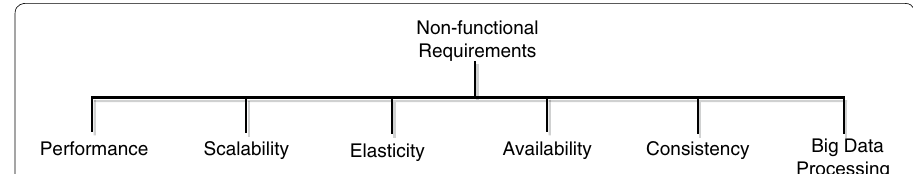
Fig. 3 Non-functional features of data management